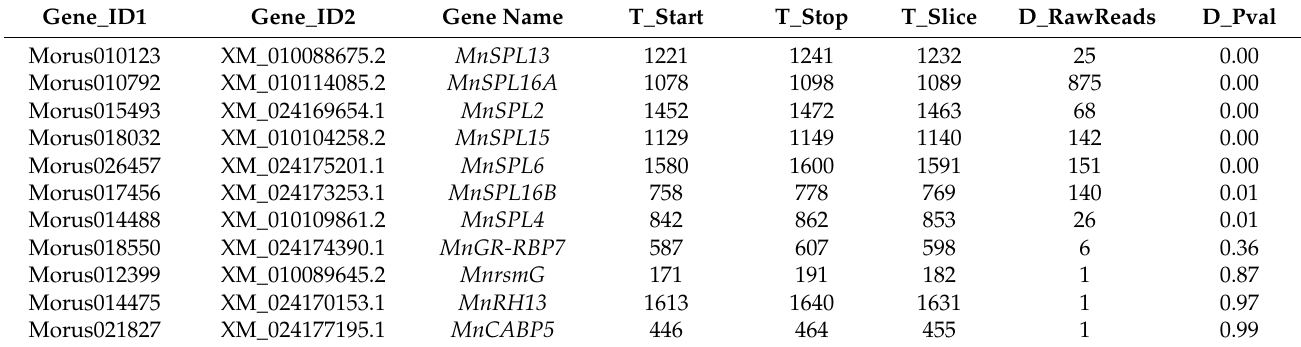
Figure 3. T-plot diagram of miR156 target genes verified by degradome sequencing. Red dots show the splice site of miR156 target genes. Table 3. Target genes of miR156 verified by degradome